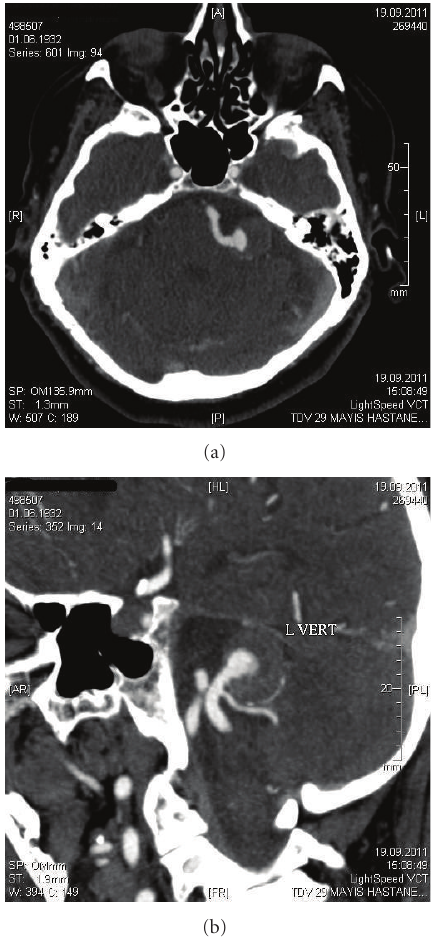
Figure 2: (a) and (b) CT angiography shows partially thrombosed saccular aneurysm with calcified walls, emerging from left PICA, just distal to its origin from vertebral artery on axial and saggital